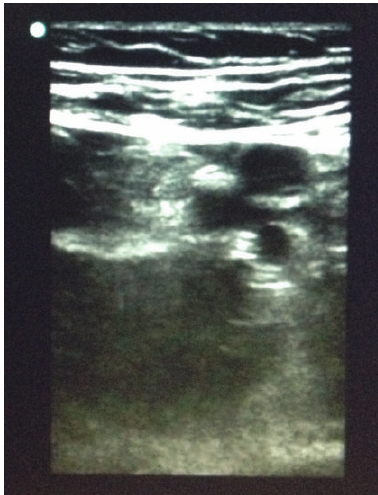
Figure 2: Compression of the deep femoral